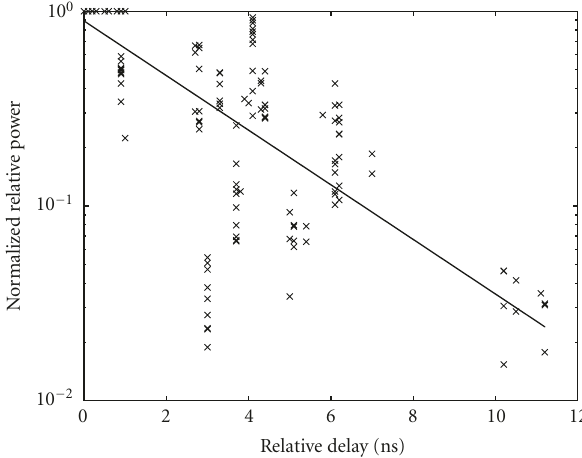
Figure 20: Average normalized path power decay for measurements beneath the Taurus chassis.